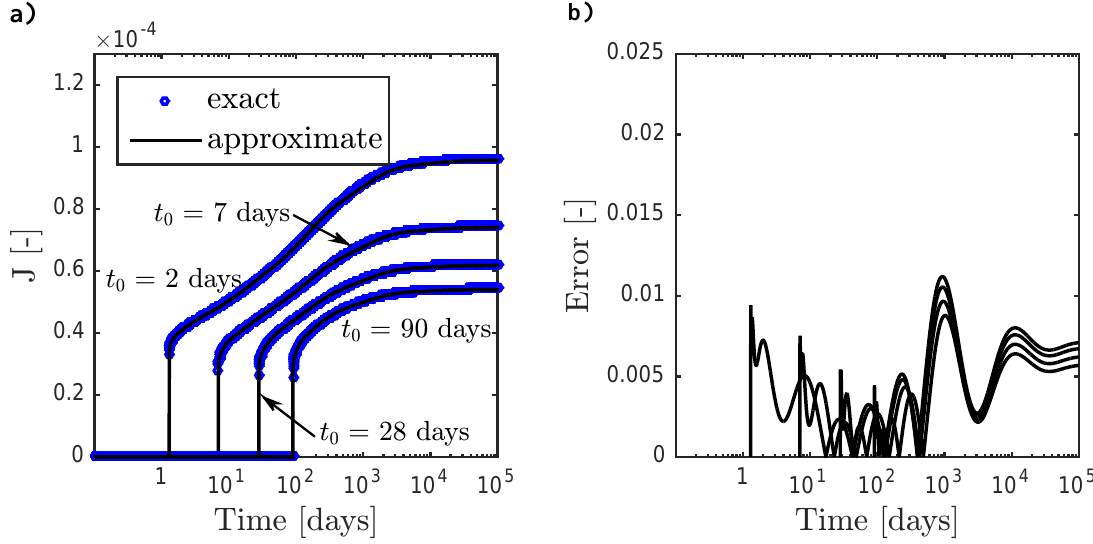
Figure 1. Approximation of the compliance functions for different t 0 (2, 7, 28, and 90 days) for the EC2 code ( a ) and the absolute value of the error between the exact and the approximated formula ( b